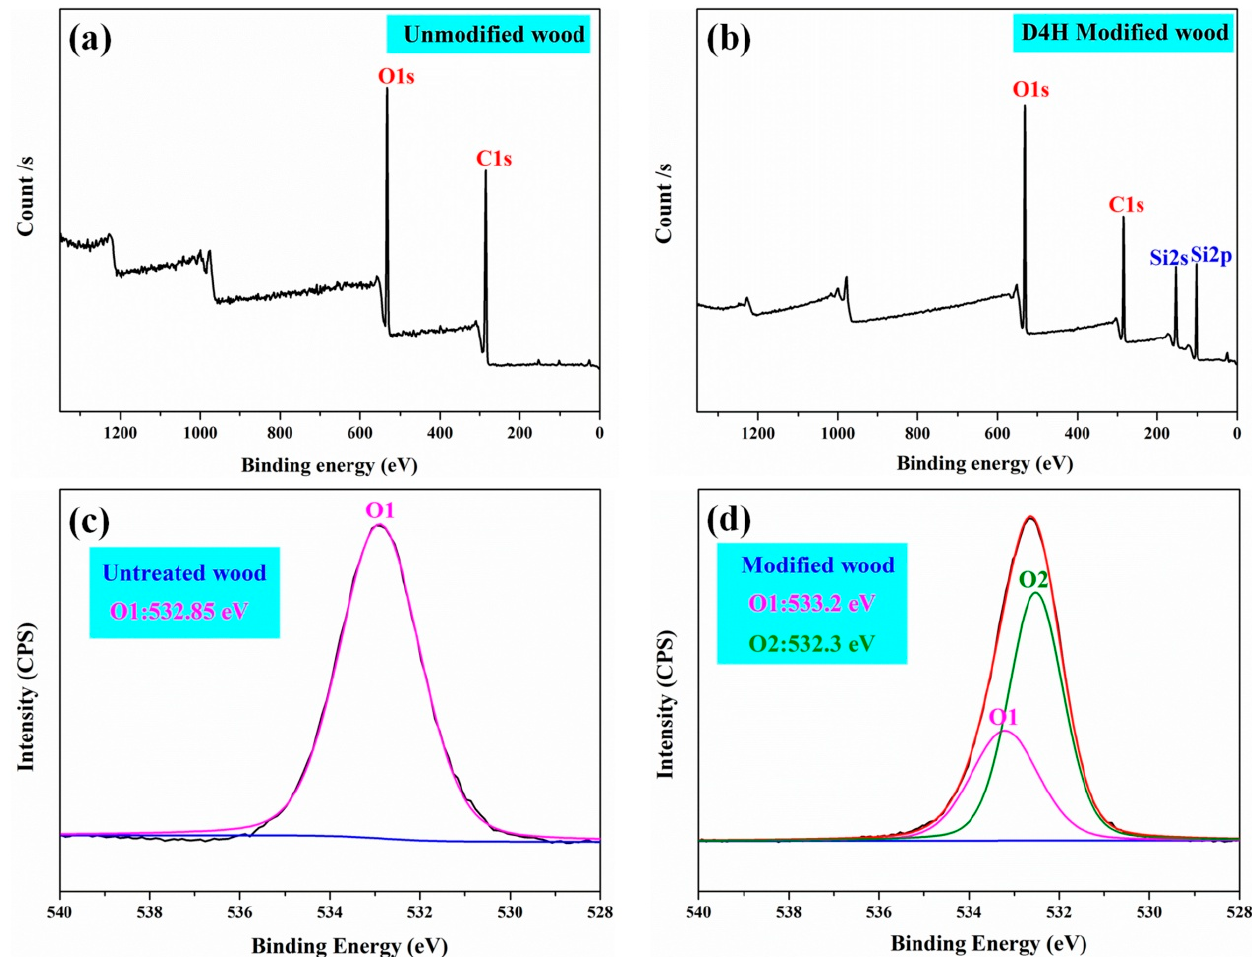
Figure 3. XPS spectra of untreated ( a ) and 25% D4H treated wood ( b ) and high-resolution spectra of O1s ( c ) and ( d ).